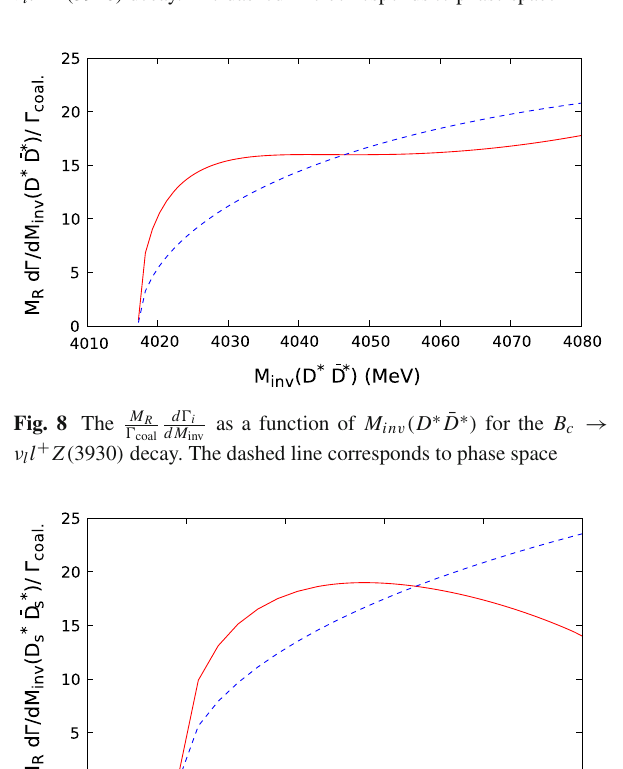
d (cid:8) i Fig. 7 The M R (cid:8) as a function of M in v ( D ∗ ¯ D ∗ ) for the B c → dM inv coal + Y ( 3940 ) decay. The dashed line corresponds to phase space ν l l